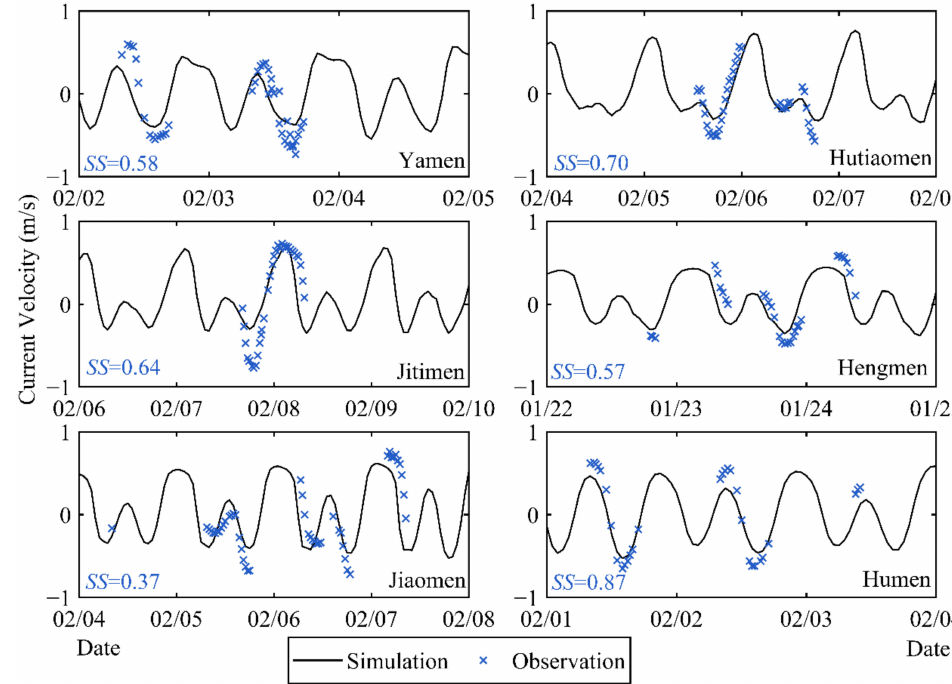
Figure 4. Validation of current